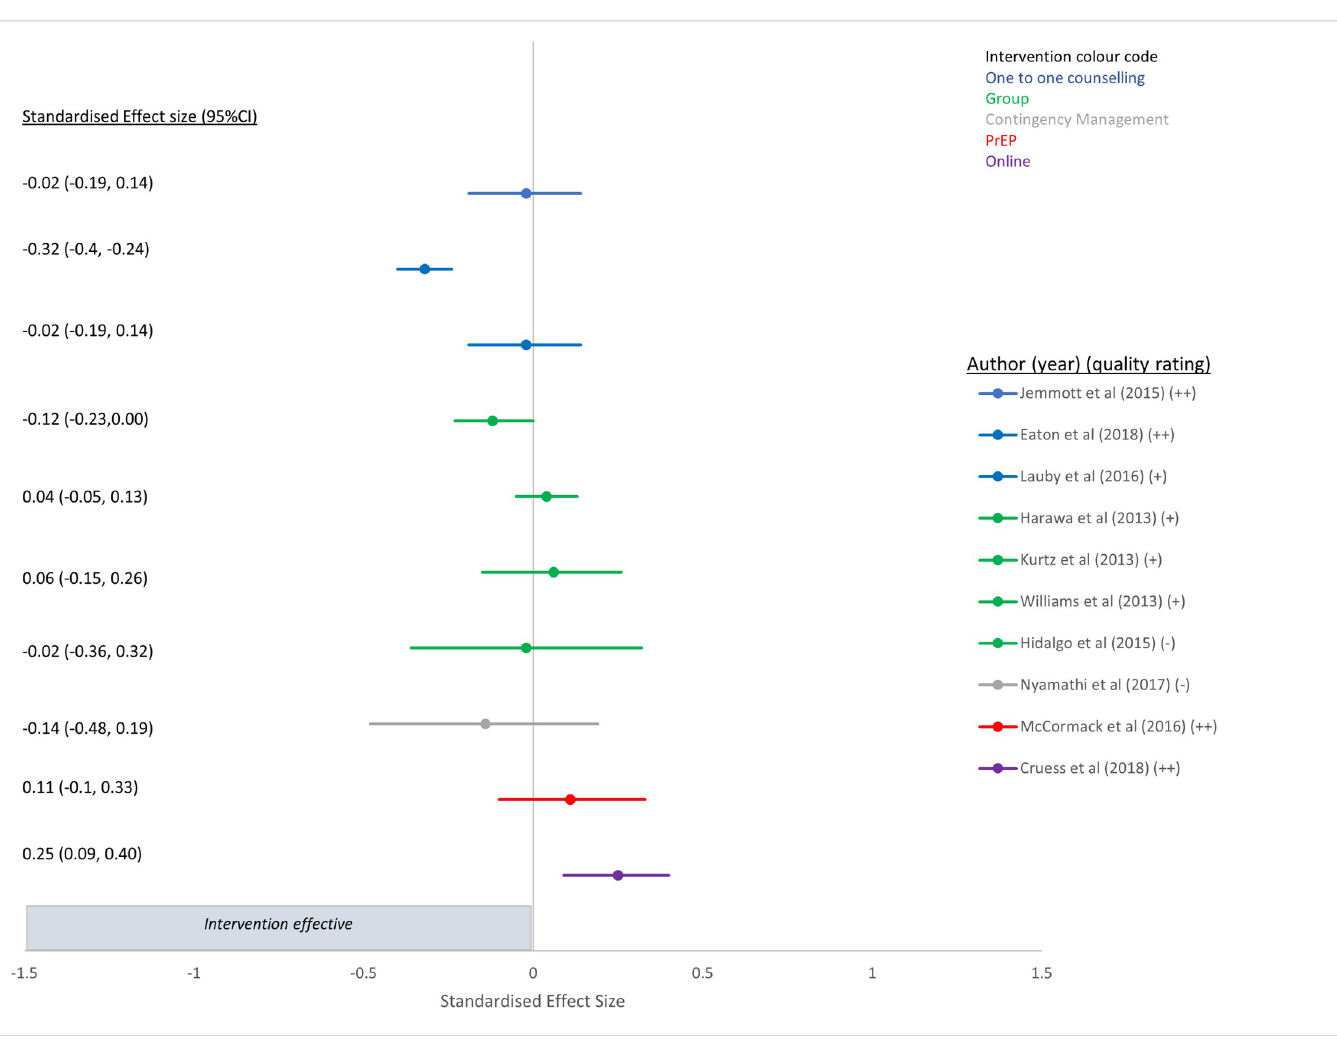
Fig 5. Intervention effect on partner